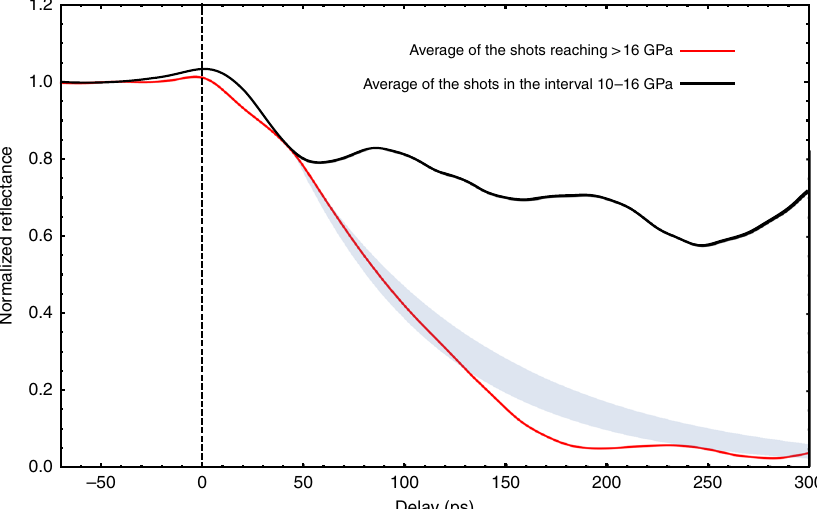
Fig. 2 The normalized re fl ectivity of the sample in the pump region as a function of time for shots above and below 16 GPa. The vertical dashed line shows the shock-wave arrival time at the ablator/LCO interface. The light gray band shows the calculated re fl ectance assuming a uniform volume fraction of carbon nanoparticles, where the absorption increases with the thickness increase of shocked material via shock propagation; the bandwidth is due to uncertainties in the dielectric function of liquid carbon, and accordingly in the estimate of the absorption depth. We assume loss due to the formation of carbon nanoparticles begins around 50 ps, where the re fl ectance of the >16 GPa data (5 shot average) signi fi cantly deviates from the 10 – 16 GPa data (9 shot average) — see Supplementary Discussion for further details. Source data are provided as a Source Data fi